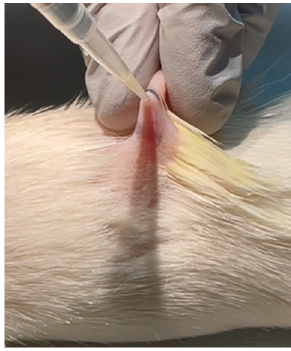
Figure 2. Representative image of generating deep skin infection on rat skin by dispelling 30 µL of saline containing 2.3 × 10 9 GFP- E. coli cells into a 5 mm-deep wound generated by an 18-gauge needle.